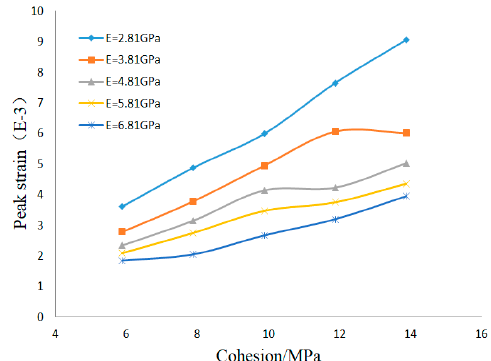
Figure 15. Influence degree of cohesion on peak strain under different elastic modulus conditions.